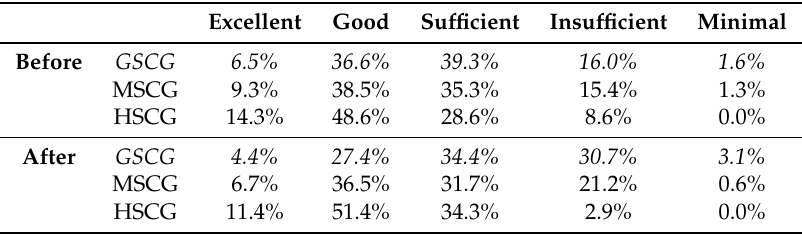
Table 1. How do you assess your knowledge on information security?